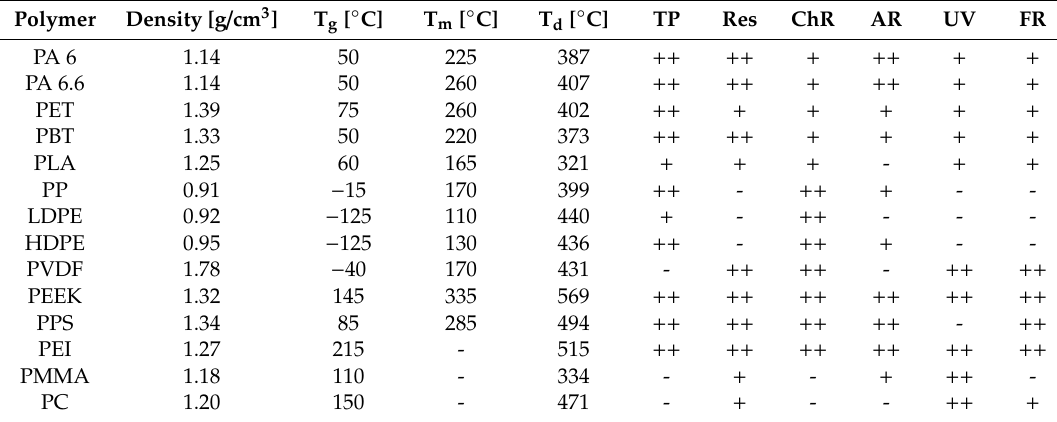
Table 2. Typical properties of selected polymers used for melt-spinning [18–27]. Density, T g and T m are average values (exact data depend on degree of crystallinity and molecular weight). In the case of PLA, 98:2 L to D lactic acid is assumed [28]. The decomposition temperature T d is defined by 5 wt% loss in N 2 , measured by thermogravimetric analysis (own unpublished data). Properties: TP = tensile properties, Res = resilience, ChR = chemical resistance, AR = abrasion resistance, UV = UV resistance, FR = flame retardancy. Performance: ++ = very good, + = acceptable, - = poor.